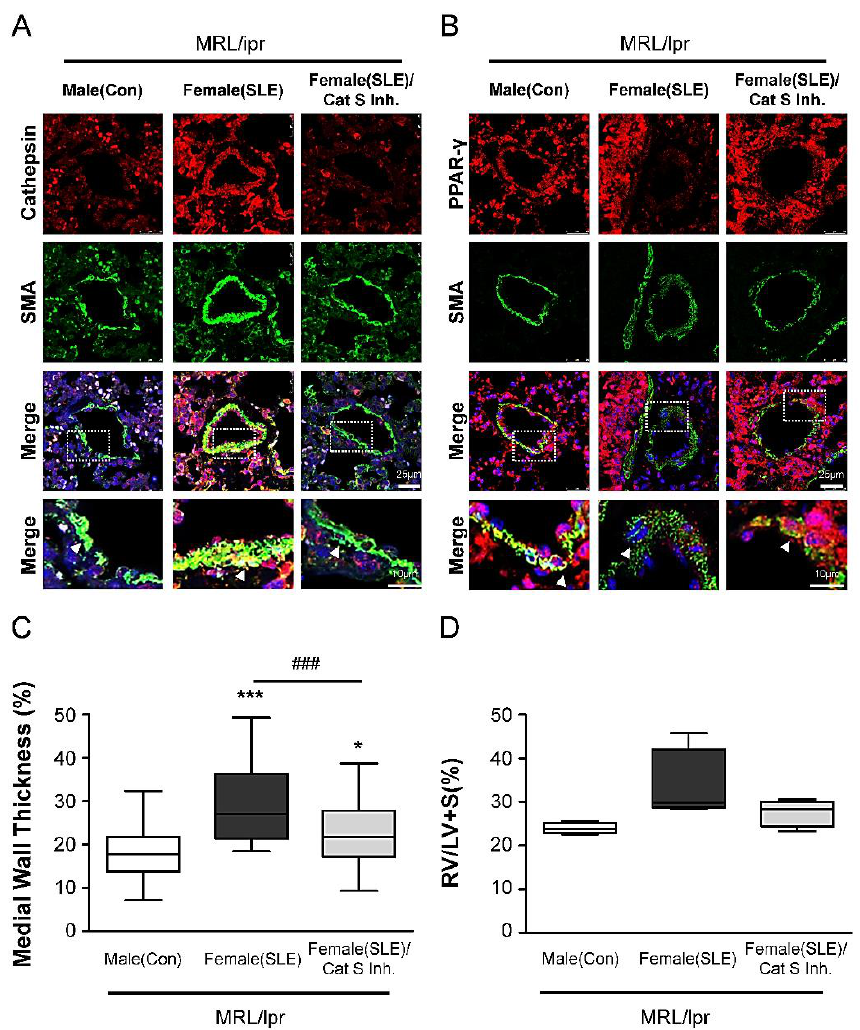
Figure 5. Effect of Cat S inhibitor in preventing the development of pulmonary arterial remodeling and right ventricle hypertrophy. ( A ) Immunohistochemistry analysis of SMA with cathepsin S, and ( B ) SMA with PPARγ in the pulmonary vascularity (scale bar: 25 μm). ( C ) Medial wall thickness (MWT) of small PAs identified by SMA staining. The degree of MWT was compared among 3 groups. ( D ) The ratio of RV to LV plus septum weight (RV/LV+S) is shown. Each value (mean ± SEM ( n = 3–5)) is expressed. * p < 0.05, *** p < 0.001 versus male MRL/lpr mice (Con) group or ### p < 0.001 compared with the female MRL/lpr mice (SLE) group, one-way ANOVA, Bonferroni post-test.